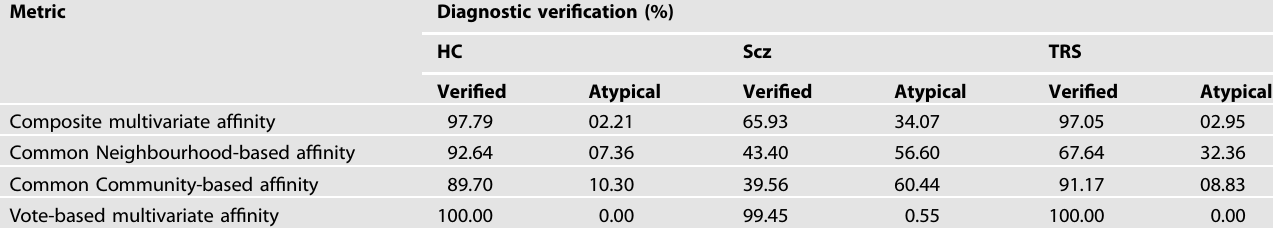
Table 4. Performance evaluation of af fi nity-based diagnostic veri fi cation framework across three diagnostic groups. Metric